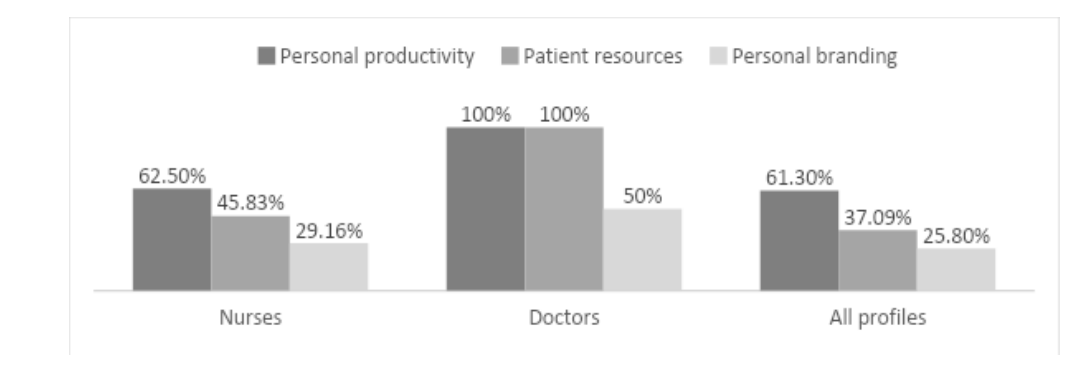
Figure 4. Comparative use of lessons learned by profiles in %.